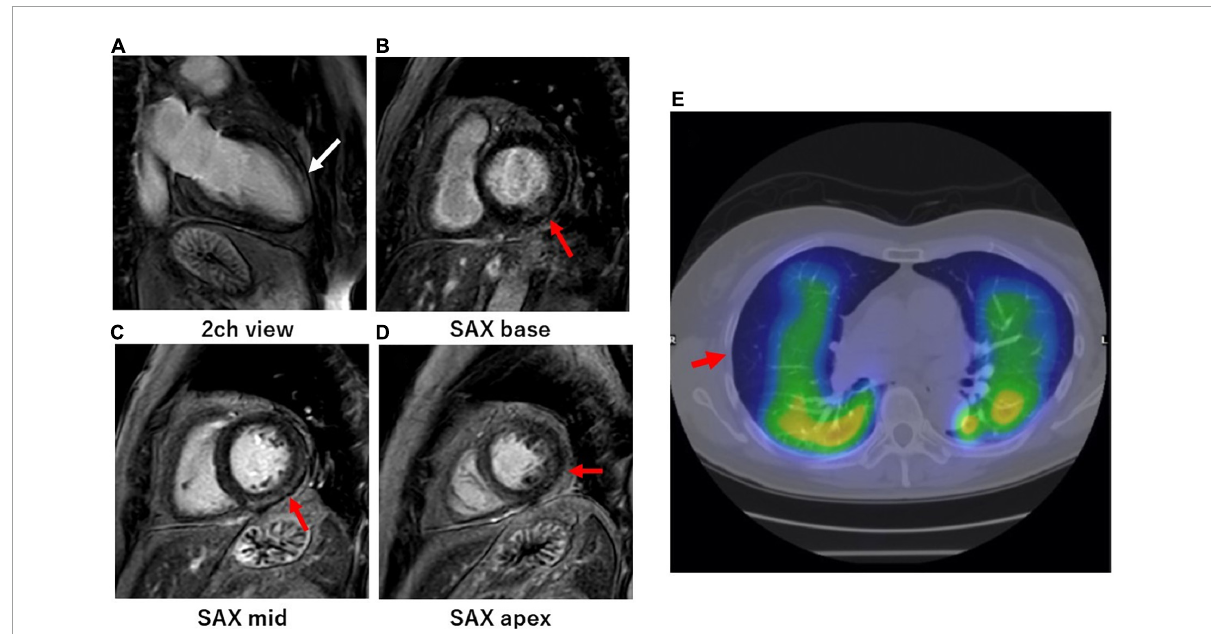
FIGURE2 Cardiac magnetic resonance of myocardial injury and SPECT/CT of pulmonary embolisms in representative long COVID patients. (A–D) A woman in her 60s visited the cardiology outpatient clinic because of persistent dyspnea and palpitations. The patient was severely ill during the acute phase of a COVID-19 infection and was temporarily managed with a ventilator. She underwent CMR at the outpatient clinic 1 month after the onset of persistent dyspnea and palpitations. CMR-LGE imaging in the 2-chamber view (A) showed intramyocardial enhancement in the mid-distal anterior wall of the left ventricle (white arrows). CMR-LGE imaging in the short-axis views (B–D) also showed endomyocardial (B) and subepicardial (C,D) enhancement on the basal-distal inferolateral wall, respectively (red arrows). (E) A woman in her 60s visited the cardiology outpatient clinic because of persistent dyspnea and chest pain. The patient was mildly ill during the acute phase of the COVID-19 infection. Lung perfusion SPECT/CT at the outpatient clinic revealed defects in the middle and lower peripheral lesions in the right lung (red arrows). Her COVID symptoms persisted for more than 6